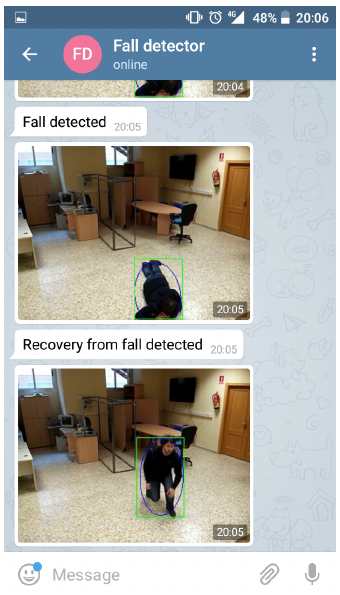
Figure 10. Fall warning delivery